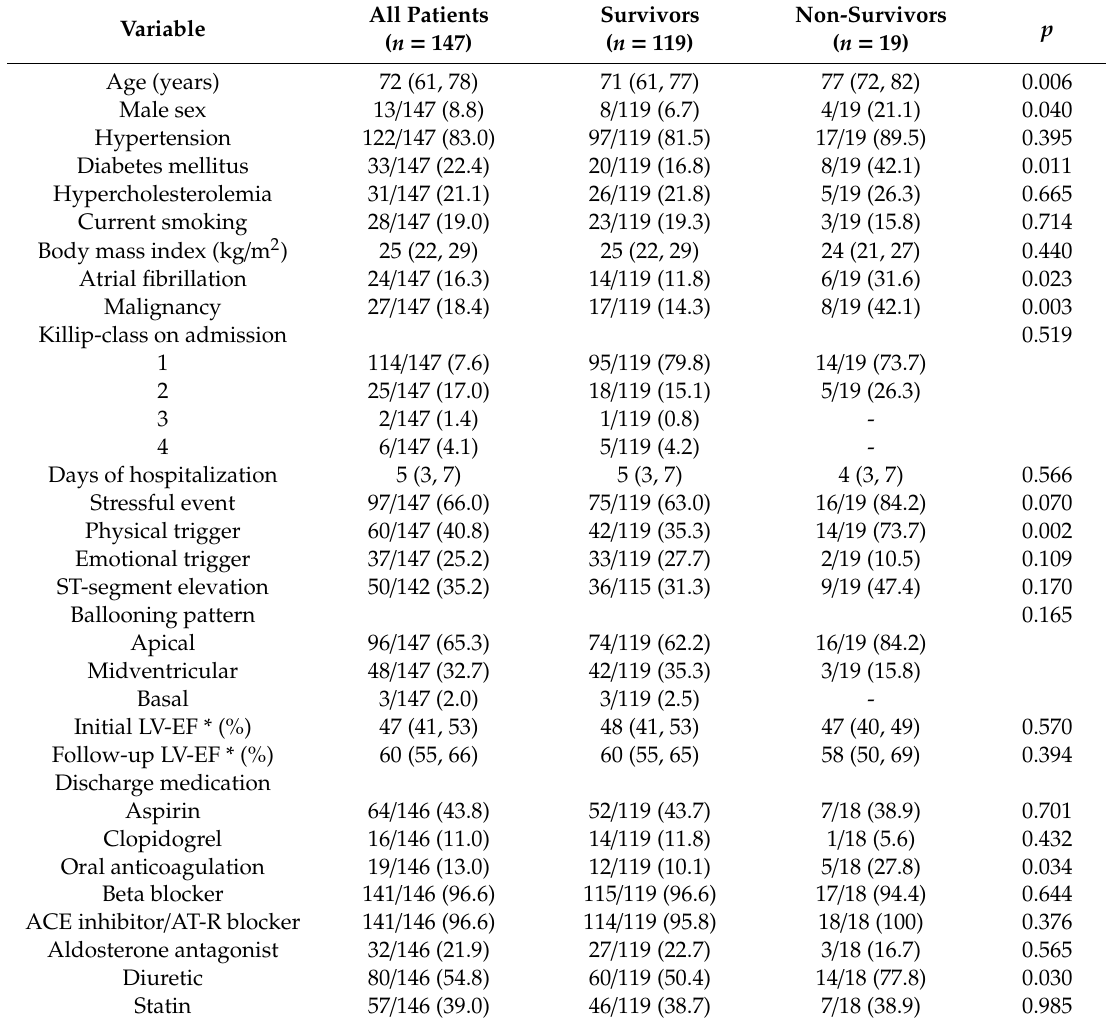
Table 1. Baseline